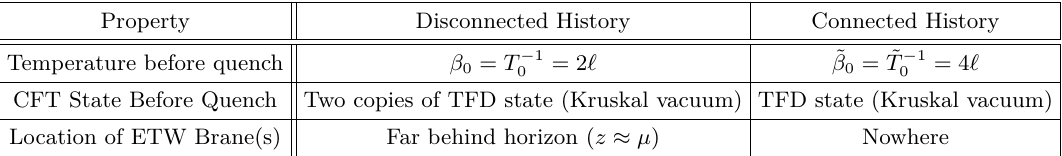
Table 2. A summary of the main properties of the two histories, shown in figure 4, that we have to consider in the dynamical